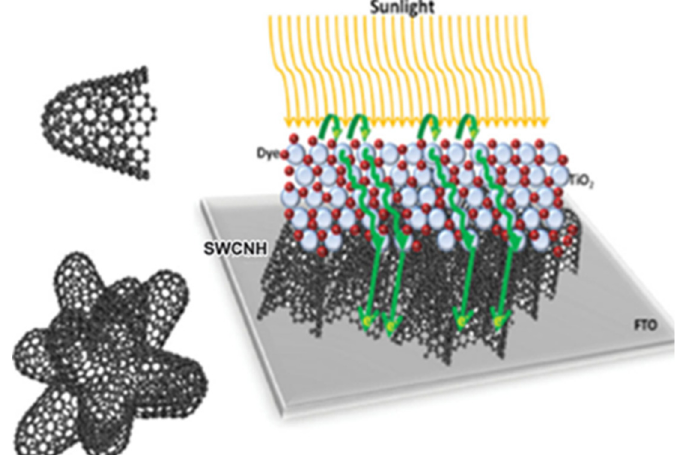
Figure 5. Left: Representation of a SWCNH ( top ) and a bundle-like SWCNH-aggregate present in solution ( bottom ). Right: Schematic representation of the proposed